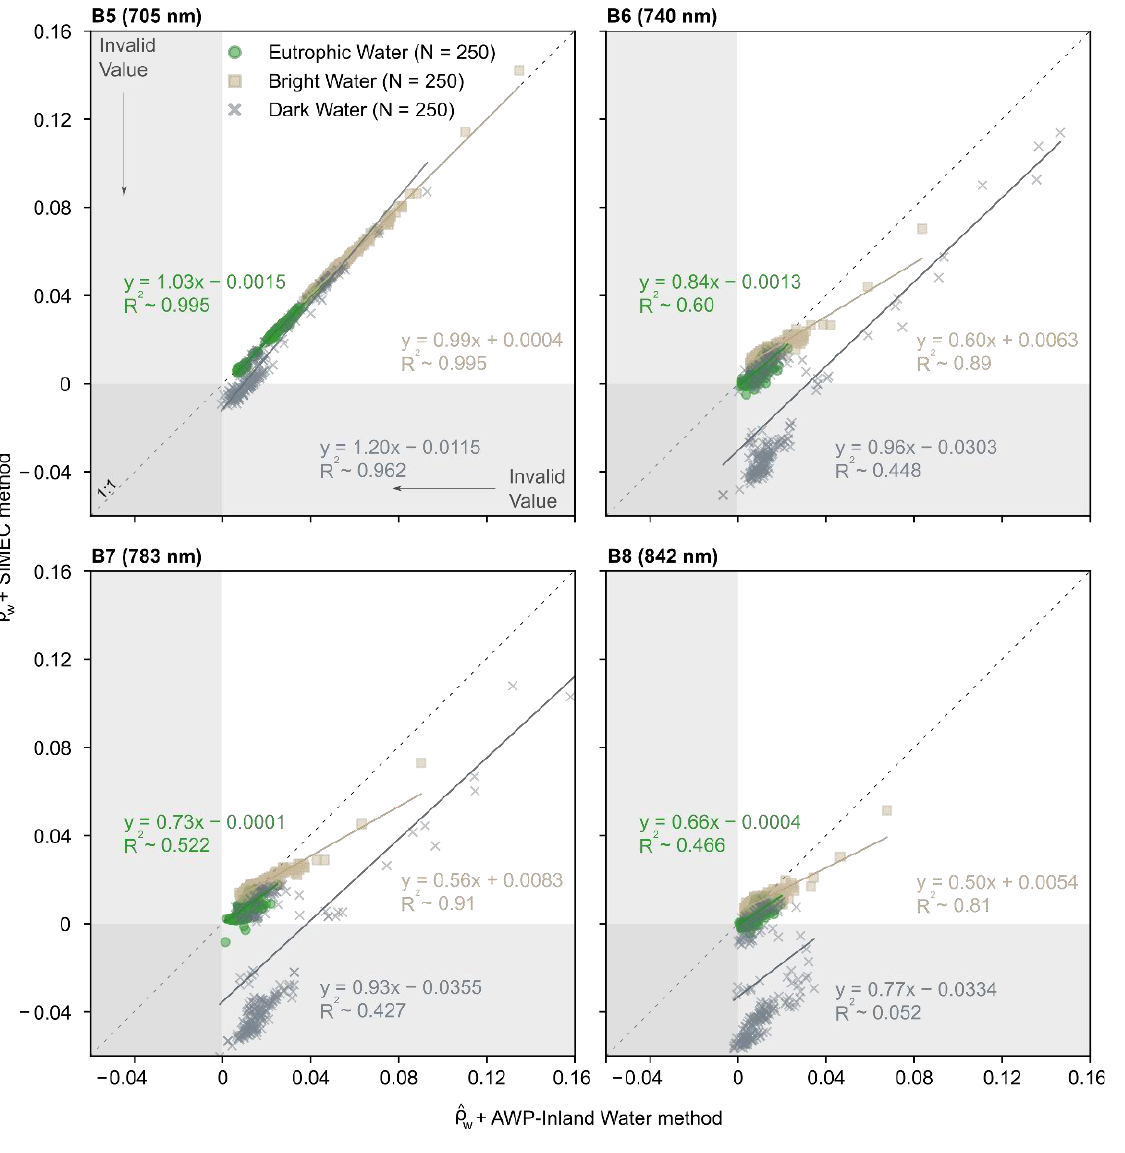
Figure 5. Water reflectance estimated from the MSI considering the range of the adjacency effect generated from SIMEC versus AWP-Inland Water. Analysis was performed for N = 250 pixels per water type. The shaded area (light gray) indicates the invalid value zone (negative values) of water reflectance resulting from AC, including the adjacency effect (Equation (3)).